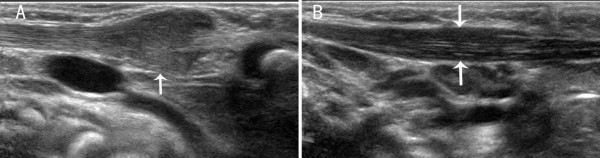
A. A vertical section of the sternocleidomastoid muscle (SCM) in a patient with early-stage muscular torticollis. B. Vertical section of the SCM of the normal side. Thickening of the affected SCM is apparent, and there are hypoechoic signals without a clear boundary. The boundary between muscular fibers is not clear, with a disappearance of the inner muscle texture.